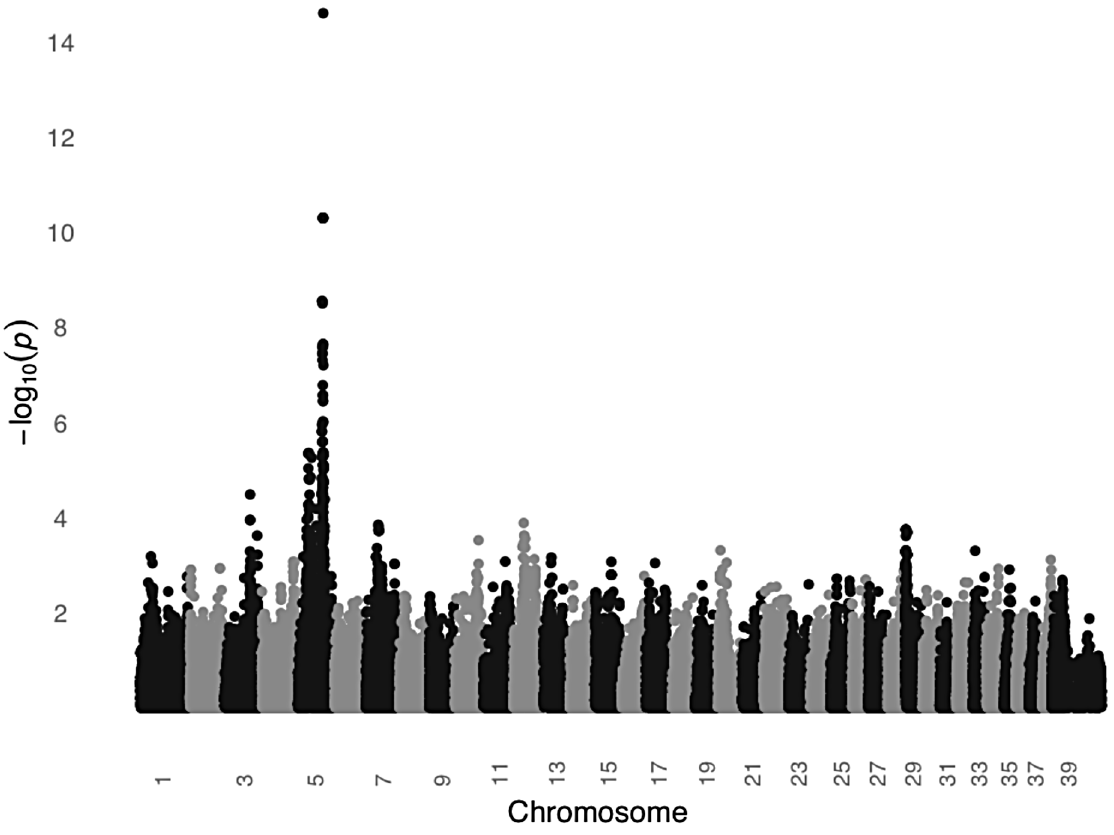
Figure 6. A significant association on CFA5 was identified in a GWAS comparing black and light colored STPOs. The GWAS compared 24 black and 24 light colored STPOs at 126,697 SNPs. Chromosome position is listed on the X-axis, and the negative log of the uncorrected P value of association of each SNP with the phenotype, as taken from EMMAX is indicated on the Y-axis. doi:10.1371/journal.pgen.1003409.g006 PLOS Genetics |